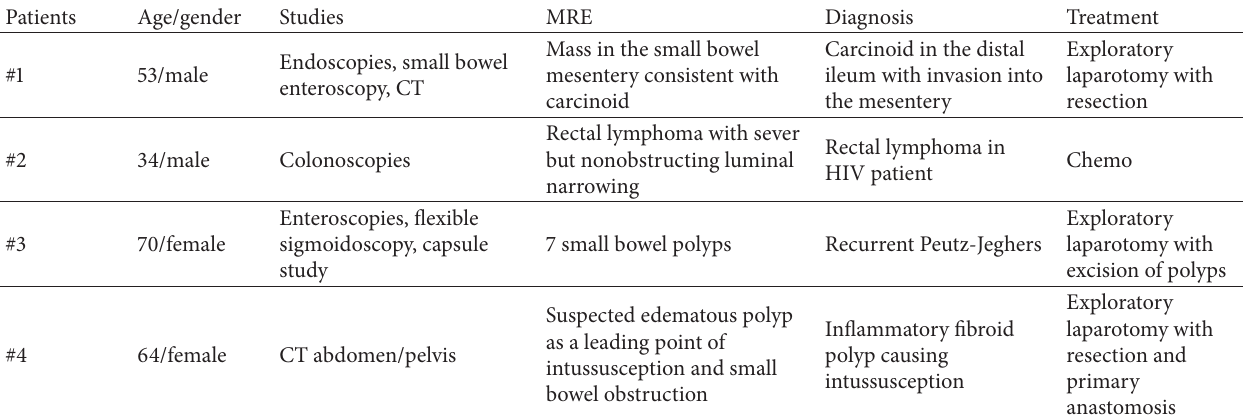
Table 1: Summary of the four